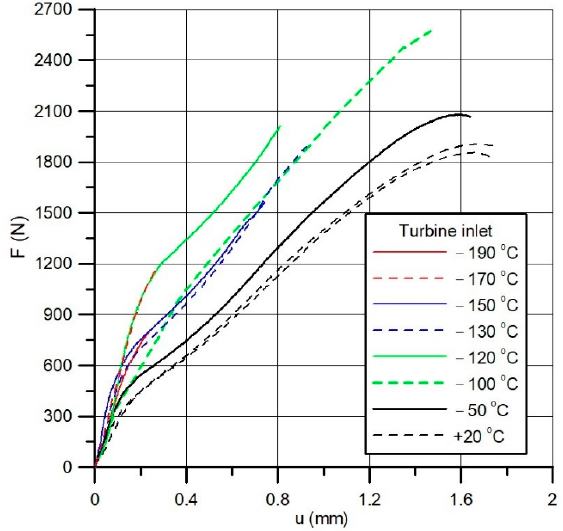
Figure 5. Testing in ambient and low temperatures–SPT curves obtained for inlet part specimens (F, force; u, displacement). Energies 2020 , 13 , x FOR PEER REVIEW